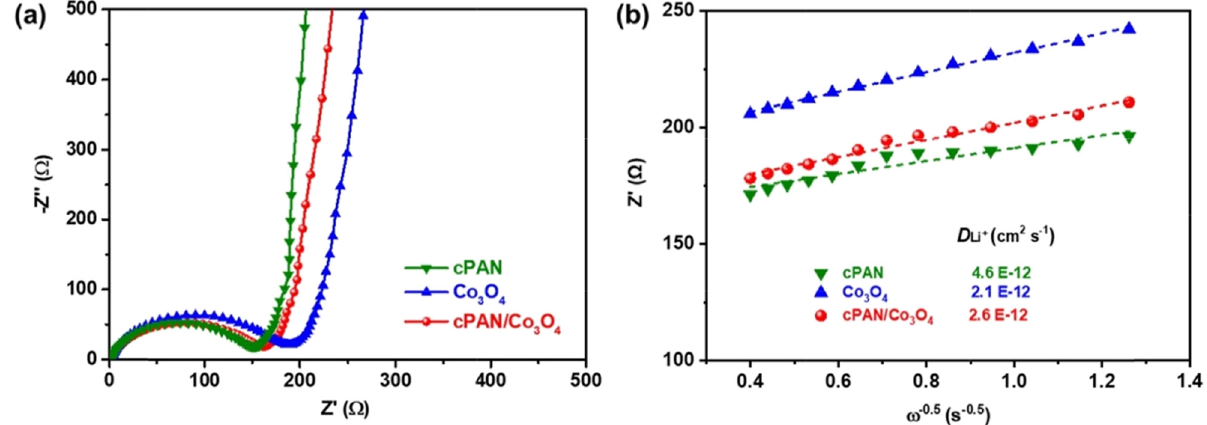
Figure 6: ( a ) Nyquist plots and ( b ) the plots of Z ′ vs ω − 0.5 for the cPAN, Co 3 O 4 , and cPAN/Co 3 O 4